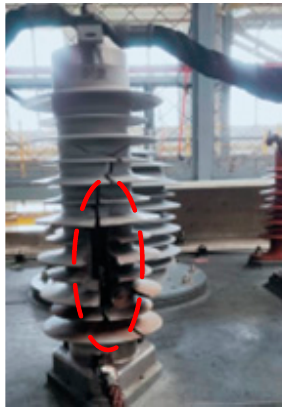
Figure 1. The scene of the accident.